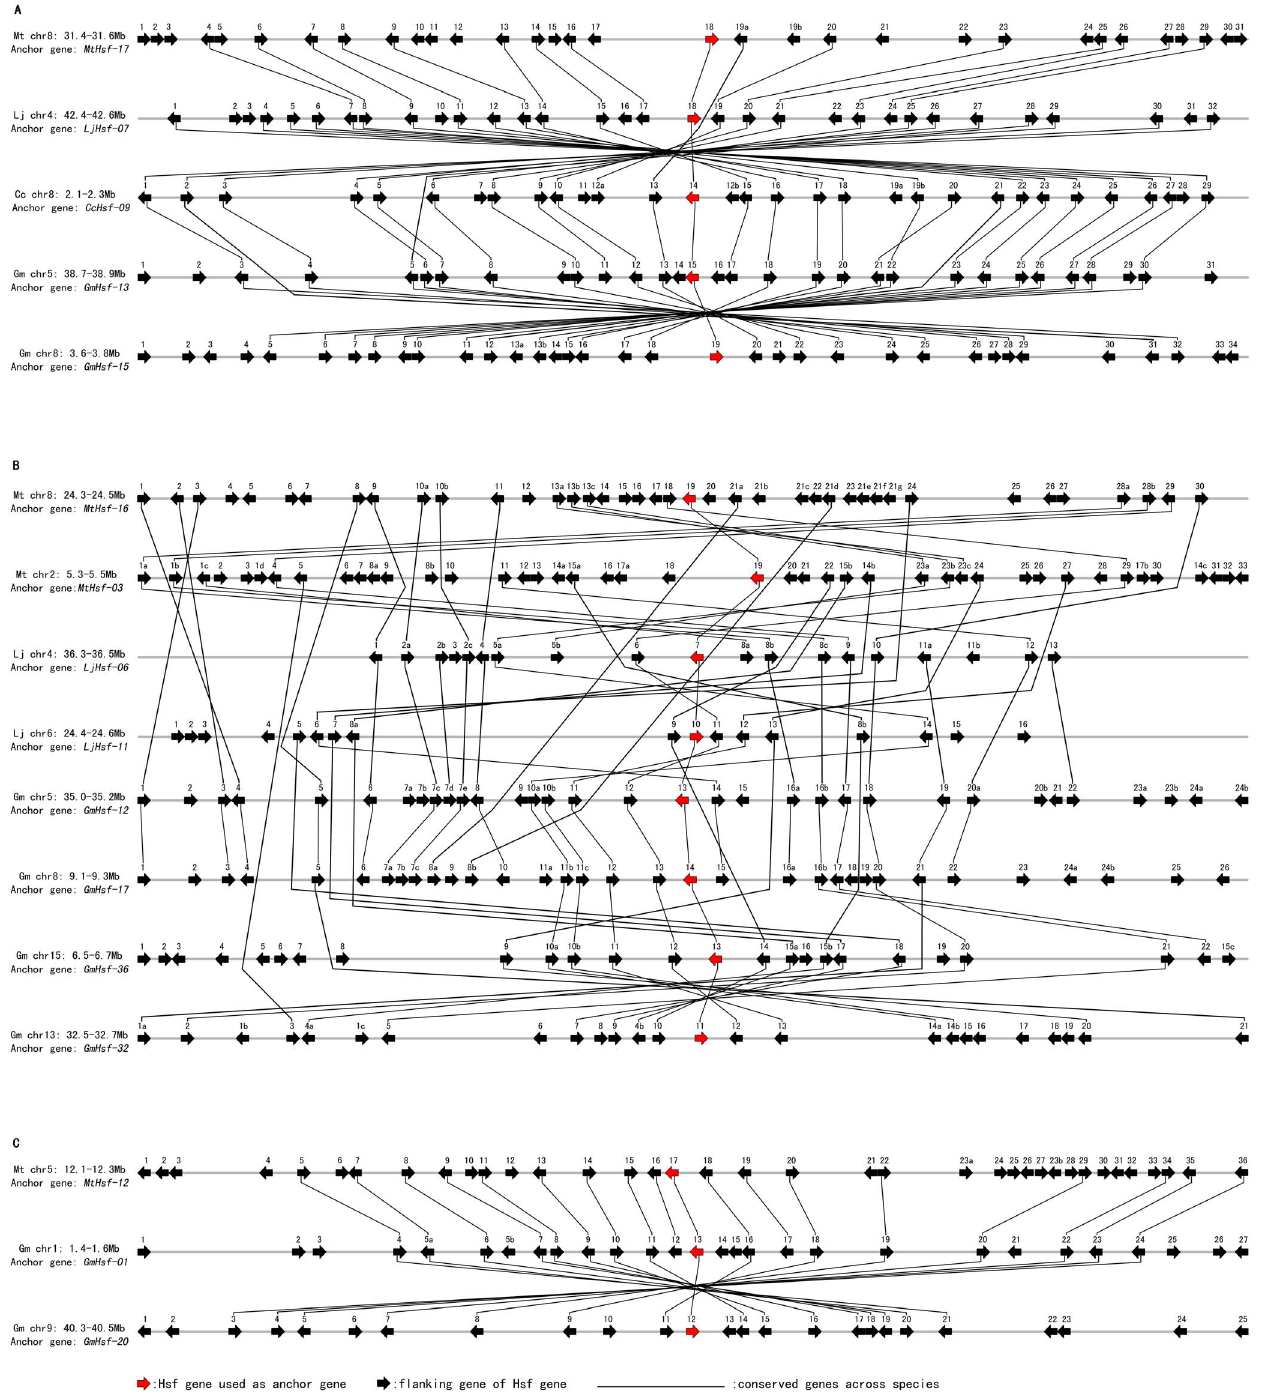
Figure 5. Comparative maps of representative Hsf genes and their flanking genes within syntenic chromosomal intervals across selected legume species. The relative positions of all flanking protein-coding genes were defined by the anchored Hsf genes, highlighted in red. The chromosome segments are shown as gray horizontal lines, with arrows corresponding to individual genes and their transcriptional orientations. All genes are numbered from left to right, in order, for each segment. Where several duplicated genes were present within a region, these genes were given the same number, with the letters a, b, c… appended in order. Conserved gene pairs among the segments are connected with lines. (A) The syntenic chromosomal intervals containing MtHsf-17 , LjHsf-07 , CcHsf-09 , GmHsf-13 and GmHsf-15 across M. truncatula , L. japonicus , C. cajan and G. max . (B) The syntenic chromosomal intervals containing MtHsf-03, MtHsf-16 , LjHsf-06 , LjHsf-11 , GmHsf-12 , GmHsf-17 , GmHsf-32 and GmHsf-36 across M. truncatula , L. japonicus , and G. max . (C) The syntenic chromosomal intervals containing MtHsf-12 , GmHsf-01 and GmHsf-20 across M. truncatula and G. max . The full microsynteny maps of the regions containing Hsf genes within M. truncatula , L. japonicus , C. cajan and G. max are shown in Figure S5.